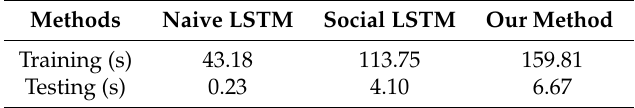
Table 4. Computational cost for training(each epoch) and testing(each